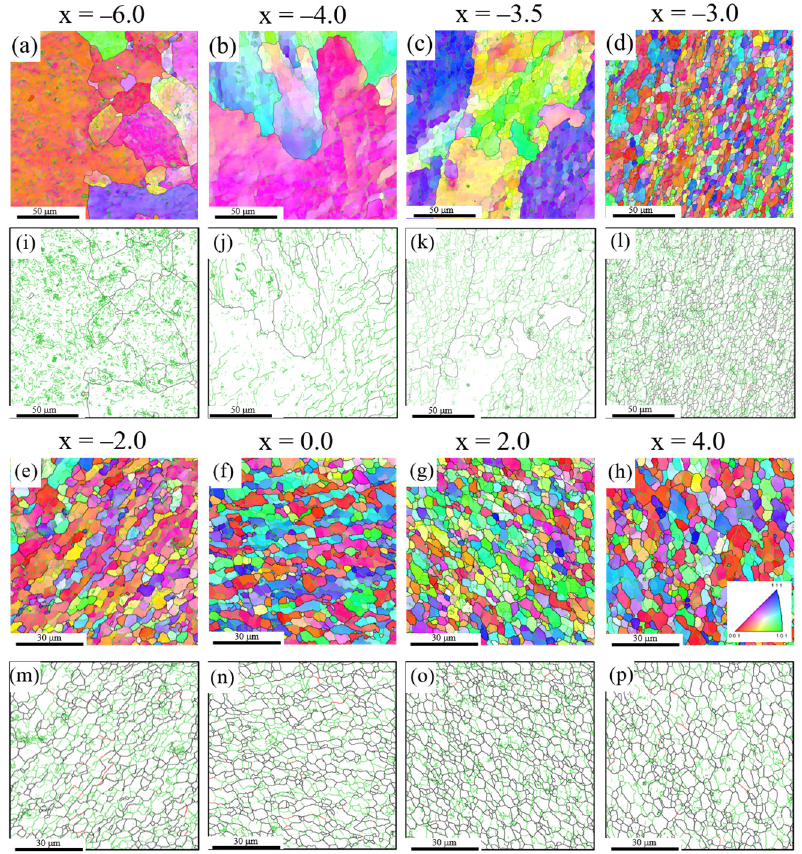
Figure 7. ( a – h ) IPF and ( i – p ) grain boundary maps for the high-purity Al joint at 0.50 T m in the range of –6.0 < x < 4.0.